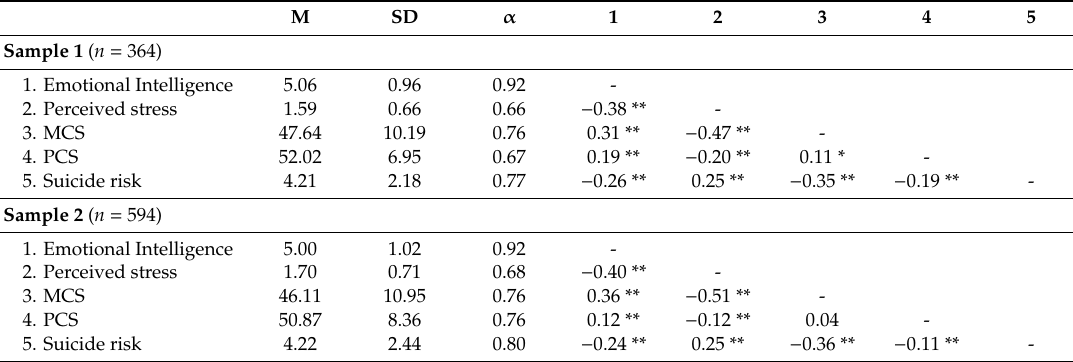
Table 1. Descriptive statistics and bivariate correlations in samples 1 and